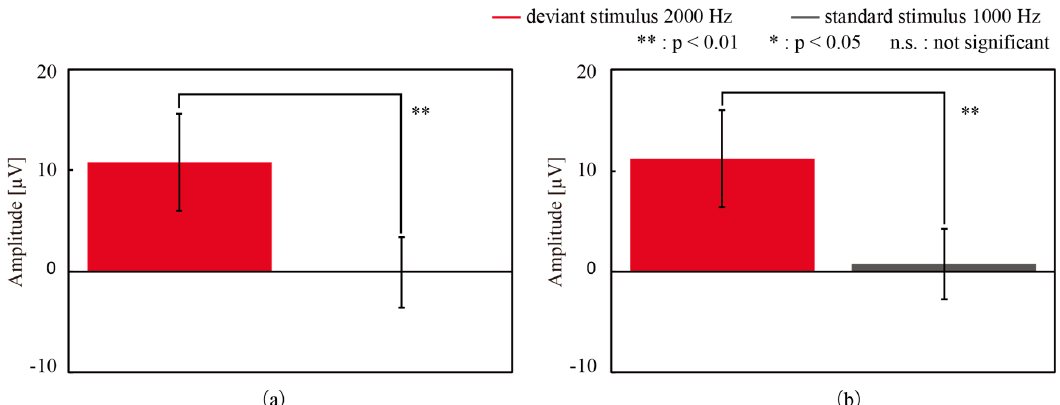
Figure 6. Grand mean waveform measured at Cz from all 10 participants after the deviant and standard stimuli measured with ( a ) CMEs and ( b ) the wet electrodes.